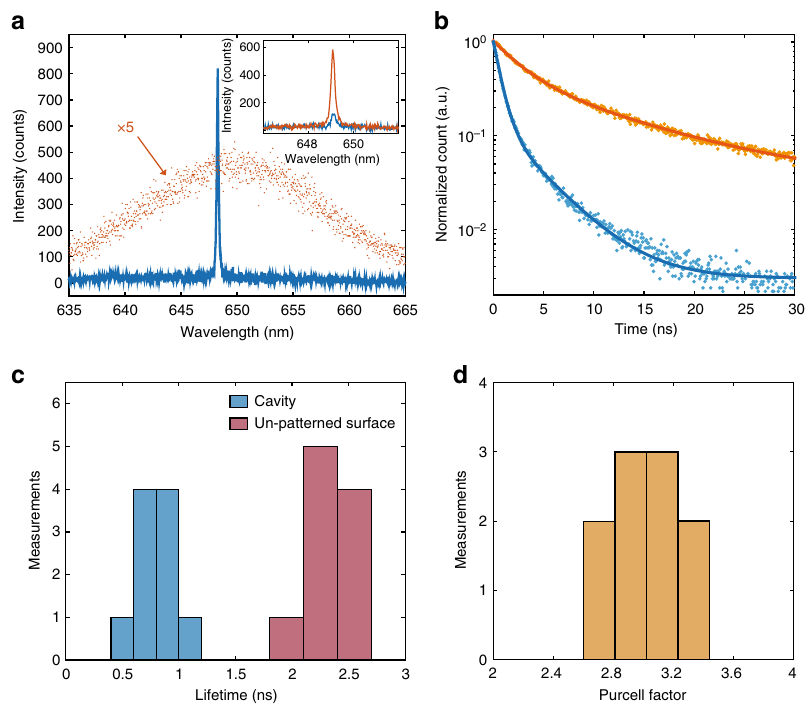
Fig. 2 Emission modi fi cation and lifetime measurements. a Emission spectra from nanoplatelets on the cavity ( blue ) and in an un-patterned region ( orange , multiplied by a factor of 5 for clarity), both measured under a CW excitation power of 10 μ W. The inset shows emission spectra taken at polarization directions parallel ( blue ) and orthogonal ( orange ) to the nanobeam. b Normalized time-resolved photoluminescence from nanoplatelets on the cavity ( blue ) and in an un-patterned region ( orange ). Dots indicate the measured data, and the lines are fi ts to bi-exponential decay model with both fast and slow decay times of τ 1 and τ 2 as fi t parameters. c Histogram of measured lifetimes for both the un-patterned regions ( purple ) and the cavities ( blue ). d Histogram of Purcell factors determined from the lifetime measurements in